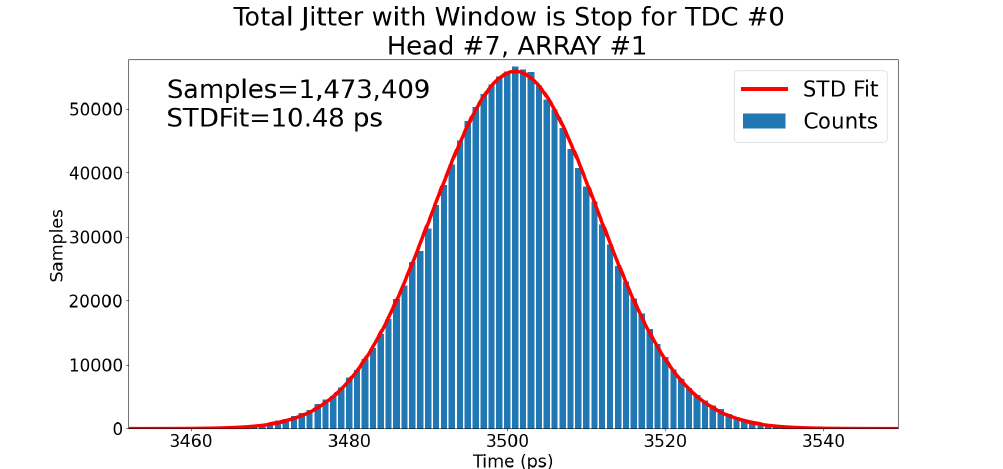
Figure 14. Total jitter of the TDC #0 of head #7 with all TDCs active with the window as the stop signal. The red line is a Gaussian fit to the whole distribution to obtain an estimate of 10.48 ps RMS for the